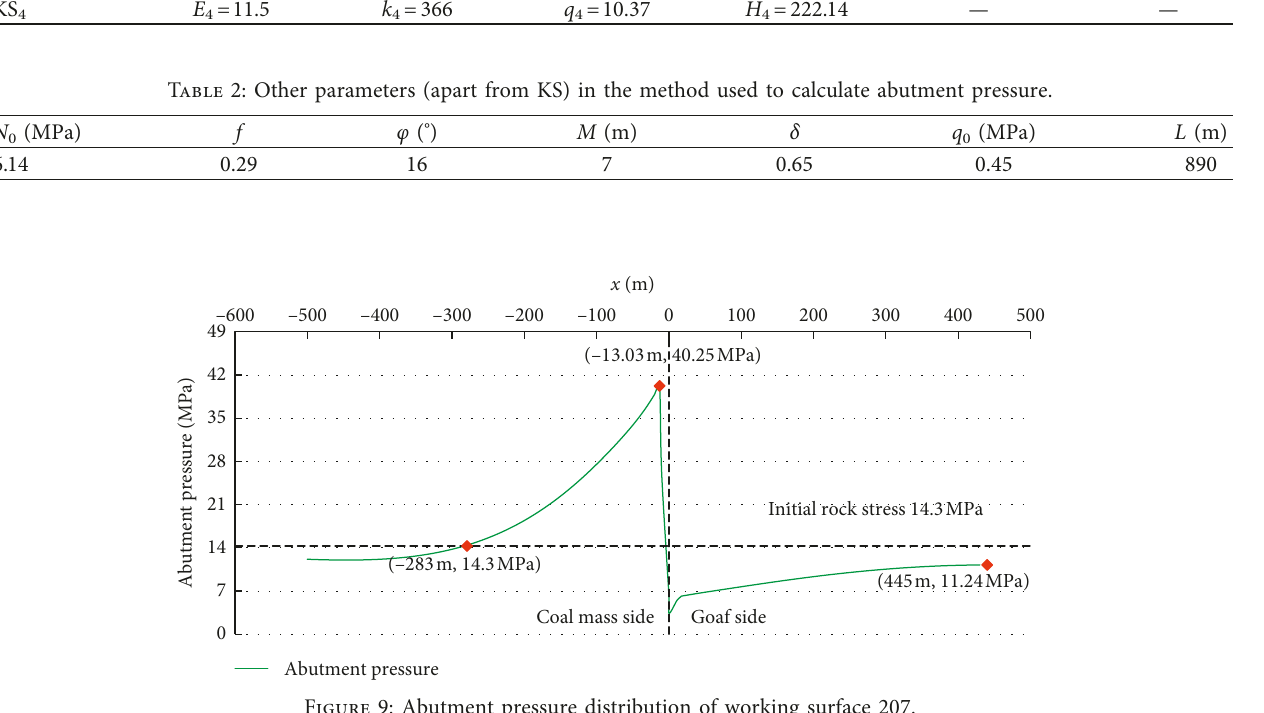
Figure 9: Abutment pressure distribution of working surface